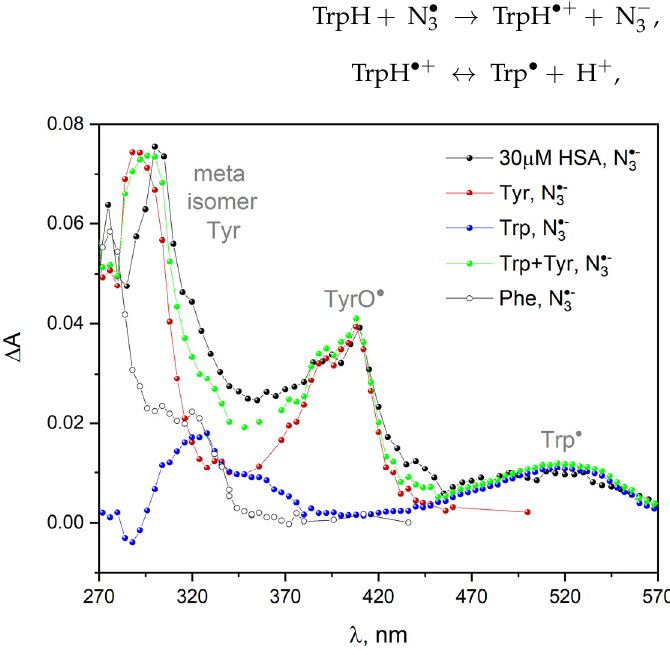
Figure 22. Transient absorption spectra of N 2 O-saturated buffer solutions containing: 30 µM HSA, 1 mM Tyr, 1 mM Trp, 1 mM Trp + Tyr, 1 mM Phe and 0.1 M NaN 3 , obtained for irradiation dose of 800 Gy. Each of the above-mentioned solutions was subjected to radiolysis separately.